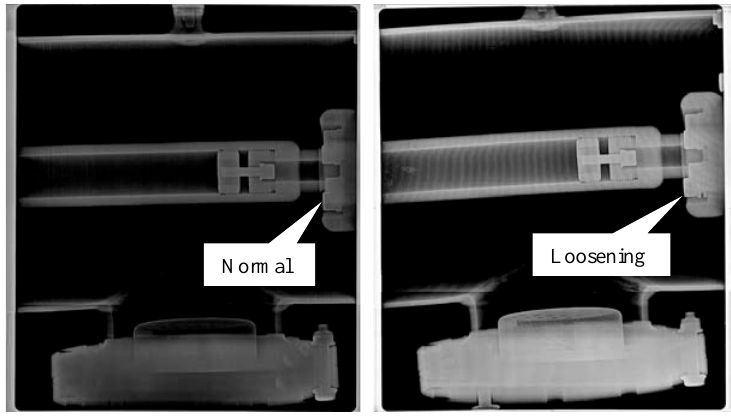
Figure 13. The normal and loosened metal screws.